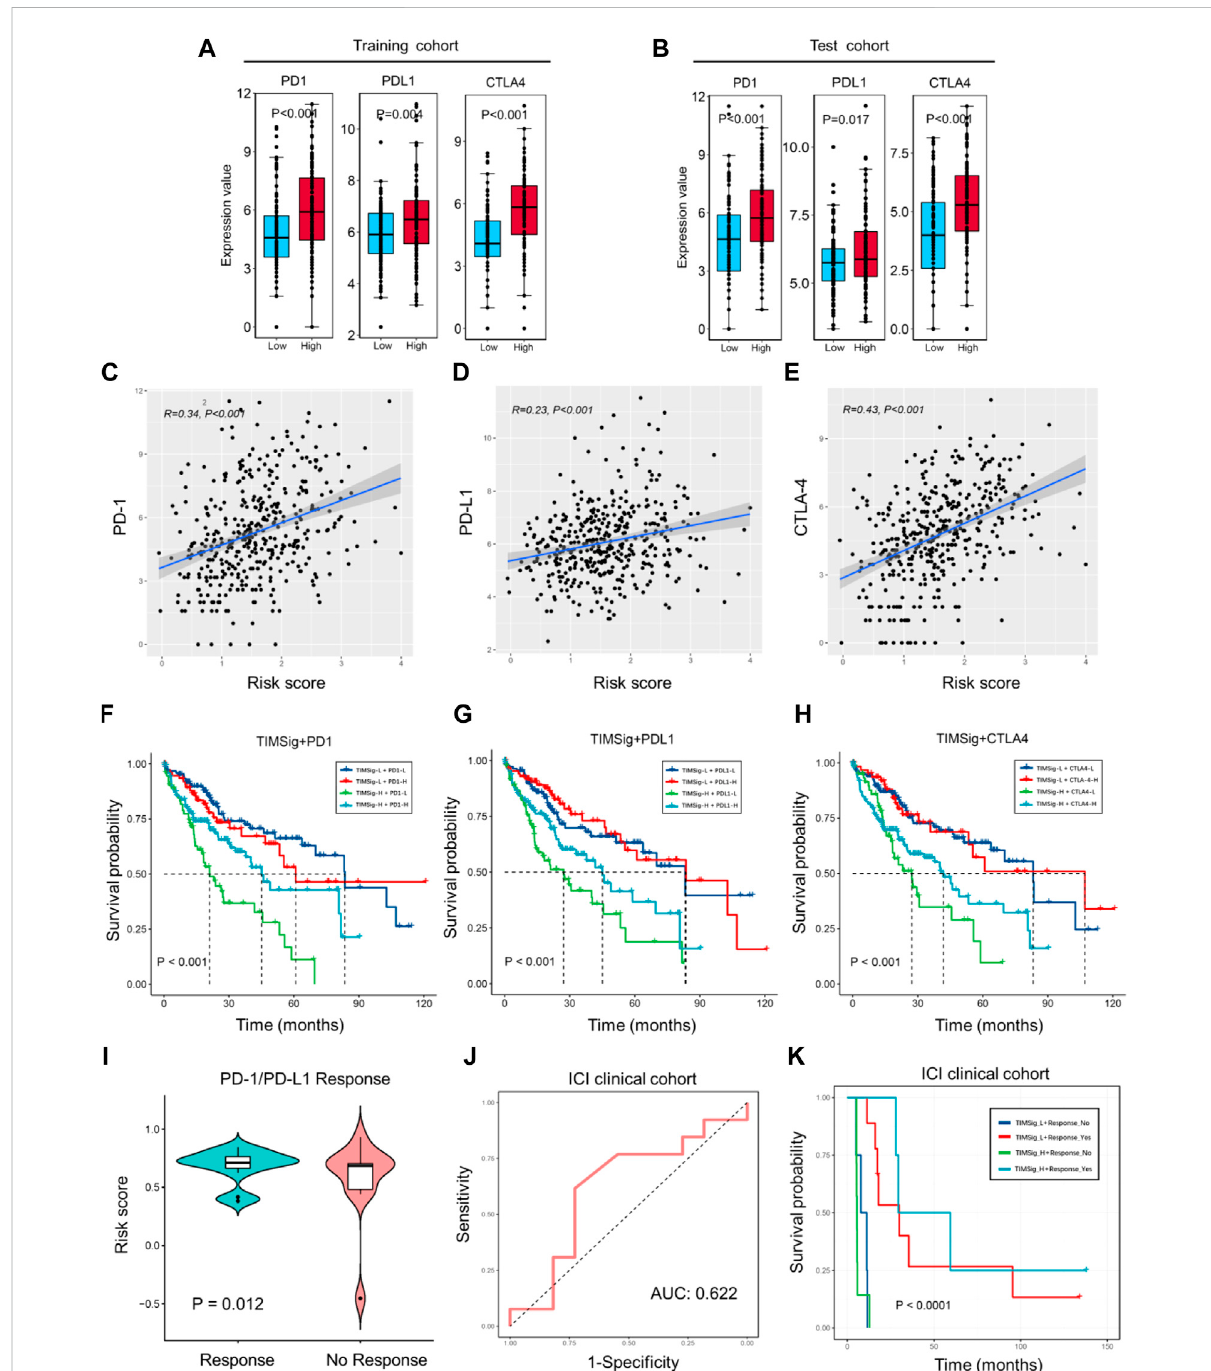
FIGURE 7 ImmunotherapyresponsewithTIMSig. (A,B) Comparisonoftheexpressionvalueofimmunecheckpoints(PD1,PDL1,andCTLA4)withdifferent groups of TIMSig in each cohort. (C – E) The Pearson correlation between immune checkpoints and the risk scores in the TCGA cohort. (F – H) K-M survival curves of OS among four patient groups strati fi ed by the TIMSig and PD1, PDL1, and CTLA4 in the TCGA cohort. (I) Comparison of the risk score with different groups of PD1/PDL1 therapy responses, paired t-test was used as the signi fi cance test. (J) The ROC curve to estimate the sensitivityofTIMSigtoPD1/PDL1therapyresponses. (K) K – MsurvivalcurvesofPFSamongfourpatientgroupsstrati fi edbytheTIMSigandPD1/PDL1 therapy